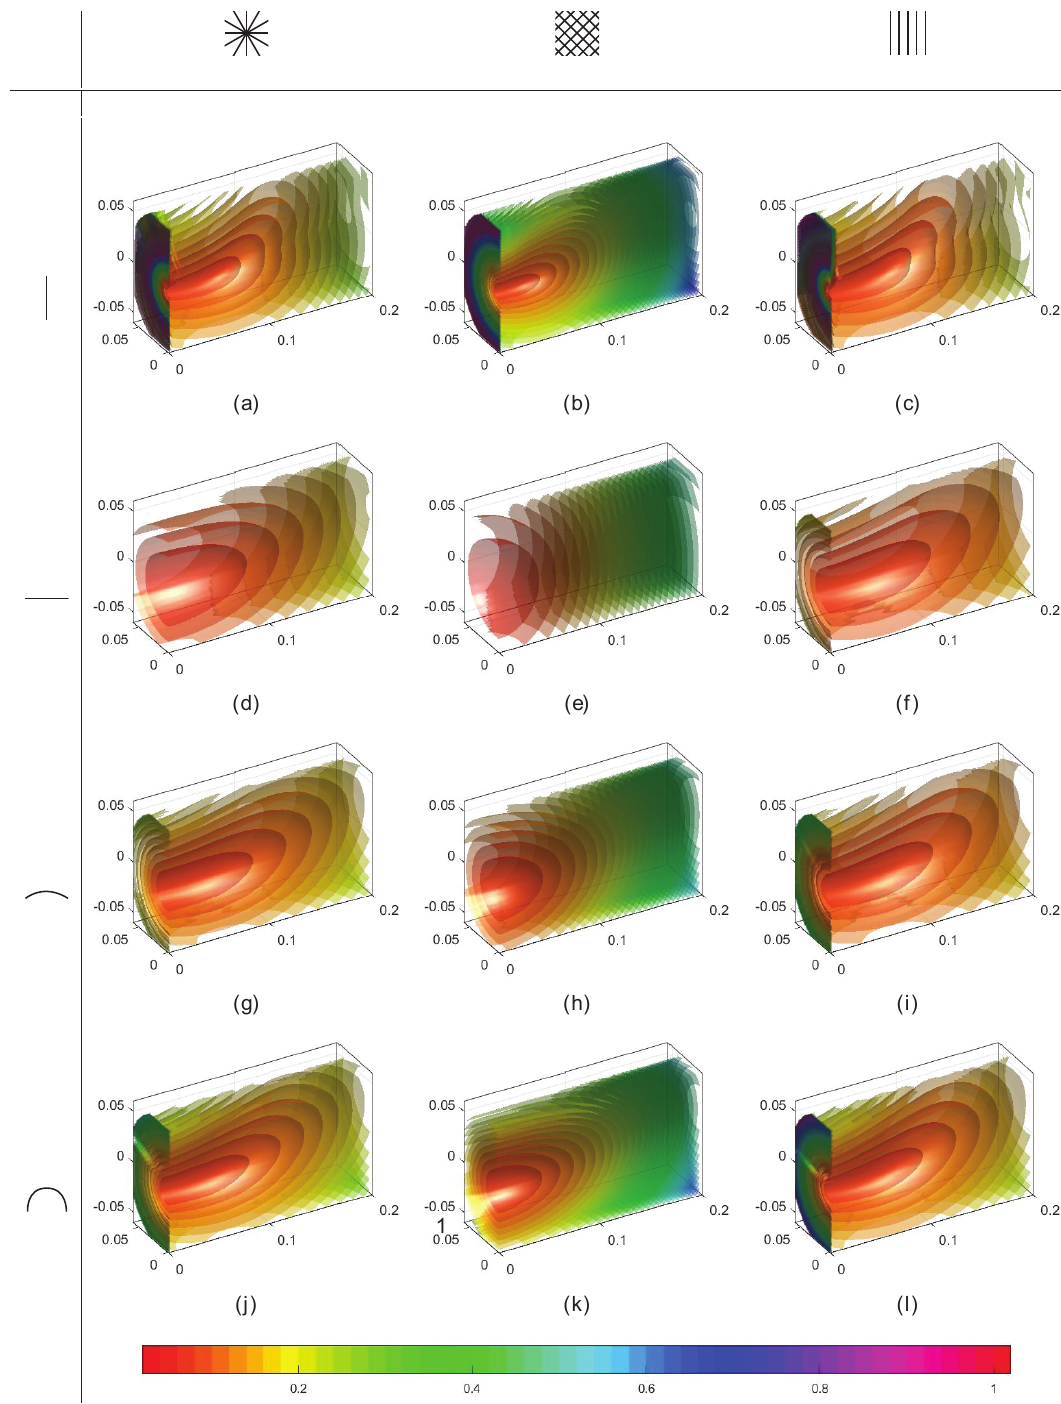
Figure 6. The PEFs of the variants of shape (flat in-plane, flat out-of-plane, arc, and U) and the variants of material orientation (quasi- isotropic, ± 45, and 0 ◦ ) are given. No prestress rotation is applied. The PEFs are sectioned at the xz -plane in order to improve the visibility of the isopotential